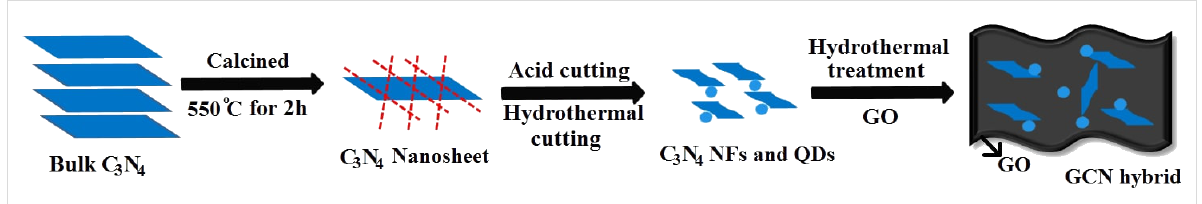
Figure 1: Schematic representation of the preparation of C 3 N 4 nanoflakes (NFs), quantum dots (QDs) and the rGO-supported C 3 N 4 (GCN) hybrid material.